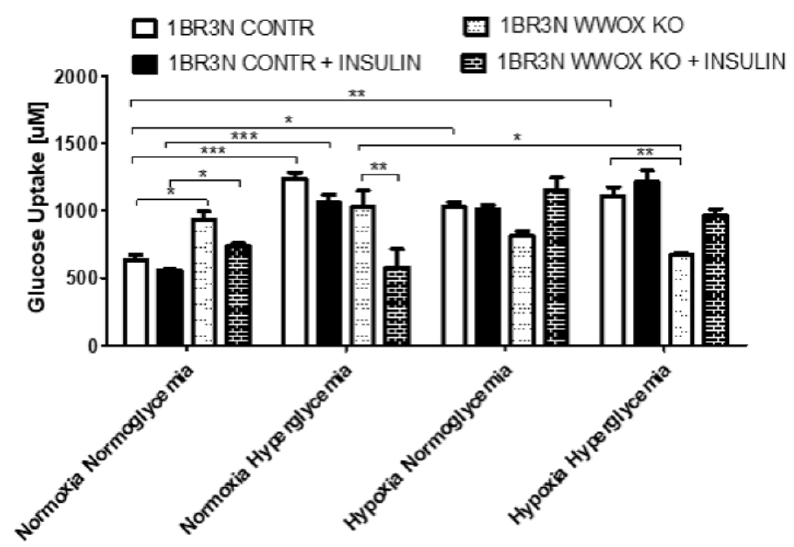
Figure 3. Glucose uptake in WWOX KO and CONTR variants of 1BR.3.N cell line incubated all tested conditions (Normoxia Normoglycemia, Normoxia Hyperglycemia, Hypoxia Normoglycemia, Hypoxia Hyperglycemia) with or without insulin for 48 h. The values are mean ± SEM. *, p < 0.05; **, p < 0.01; ***, p < 0.001.